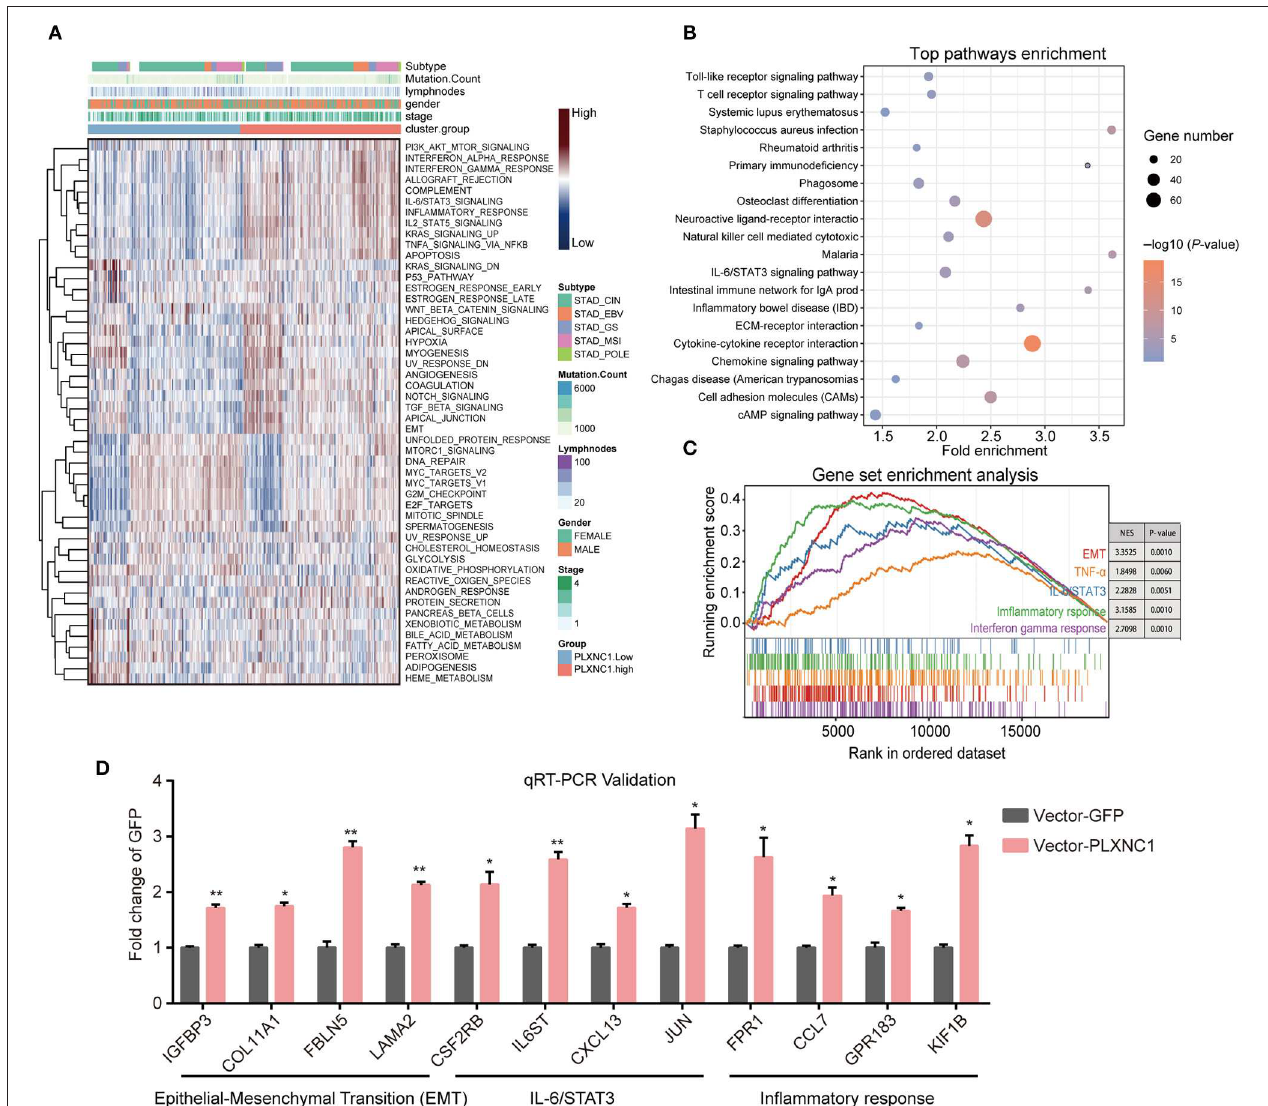
FIGURE 4 | PLXNC1 activates cancer-associated signatures in gastric cancer. (A) The heatmap of hierarchical clustering shows the enrichment score of cancer hallmark gene sets enriched in the PLXNC1 high/low expressed group based on single sample gene set enrichment analysis (GSEA) for TCGA-STAD cohort. (B) KEGG pathway analysis performed by the DAVID platform for PLXNC1 high-expressed group. The KEGG pathway with P < 0.05 is shown in a bubble plot. (C) GSEA of hallmark gene sets in high-level-group of PLXNC1. All transcripts were ranked by log2 (fold change) between two groups. Each run was performed with 500 permutations. Enrichment results with significant associations with PLXNC1 were shown. (D) The relative candidate cancer hallmark pathway gene mRNA expression infected with PLXNC1 or GFP overexpression lentivirus in AGS gastric cancer cells using qRT-PCR analysis. (D) Values represent the mean ± SEM, n = 3. * P < 0.05; ** P <